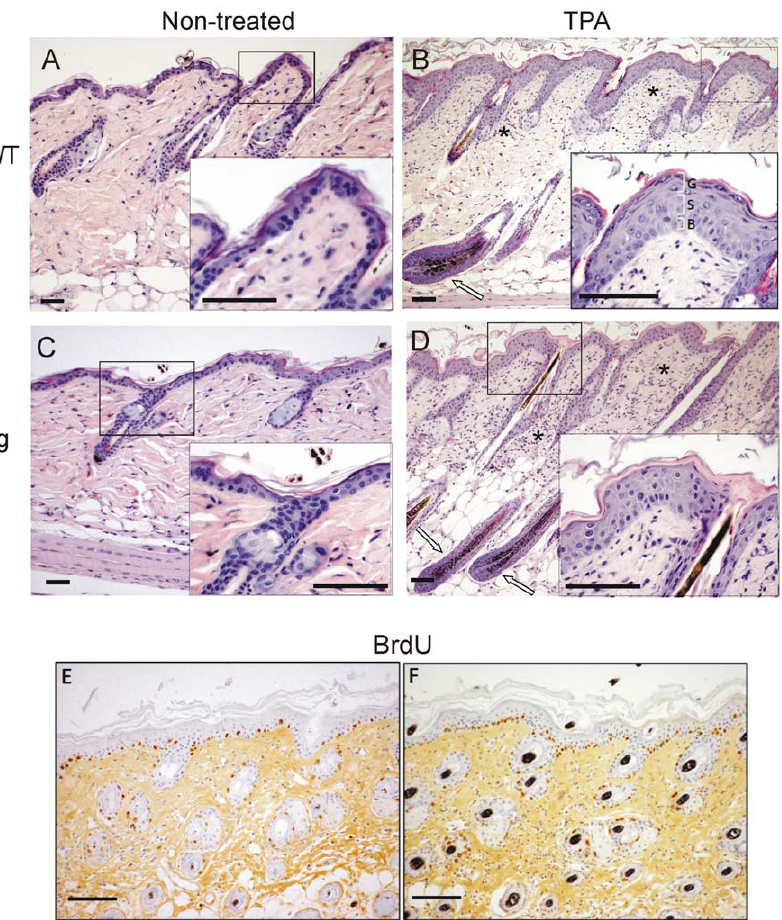
Figure 3. Atypical epidermal hyperplasia in skin of K5-IKK a -Tg mice subjected to TPA treatment. ( A–D ) Representative paraffin-sections of skin from WT ( A–B ) and K5-IKK a -Tg mice ( C–D ) were stained with hematoxilin/eosin. ( A, C ) Non-treated skins; ( B, D ) TPA treated skins. ( B ) Hyperplastic epidermis induced by topical application of TPA in WT mice. White arrow indicates a hair follicle in the anagen phase. (Inset in B) B: stratum basale , S: stratum spinosum , G: stratum granulosum . Conservation of squamous differentiation is clear in WT epidermis where marked hyperplasia of stratum spinosum (acantosis) and stratum granulosum (hipergranulosis) are observed as common facts of typical epidermal hyperplasia. ( D ) Hyperplasia and epidermal atypia with loss of cellular architecture in TPA-treated Tg skin. White arrows indicate hair follicles in the anagen phase. (Inset in D) Epidermal hyperplasia in K5-IKK a -Tg mice shows an atypical proliferating epithelium with all strata conformed by keratinocytes with round, central nuclei highly basophilic (pyknosis). The stratum granulosum of flattened cells with cytoplasm filled with keratohyaline granules were not formed. Asterisks in B, D points to regions of the lichenoid inflammation with diffuse infiltrates of mononuclear cells found in skin of both WT and Tg mice after TPA treatment. ( E, F ) BrdU incorporation in skins from WT ( E ) and Tg ( F ) mice treated with TPA. ( A–F ): scale bars=50 m m.